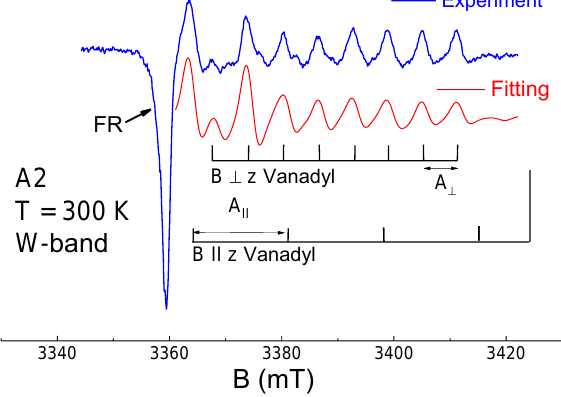
Figure 3. W-band cw EPR for A2 fraction.